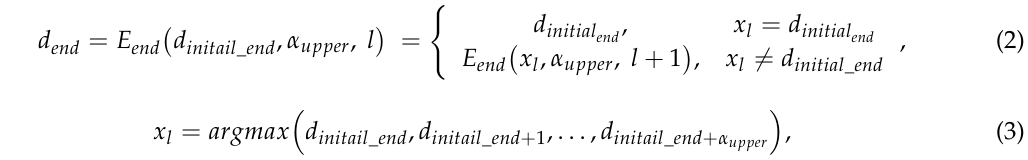
Figure 5. Tri-axial acceleration of a subject performing floor mopping. ( a ) The threshold is determined by the dominant axis (acceleration of the X-axis). Each circle denotes the detected event, which contains starting and ending points, and crossing the threshold in ascending order. ( b ) The covered region by the starting and end points denote the searched candidate for significant change spotting.